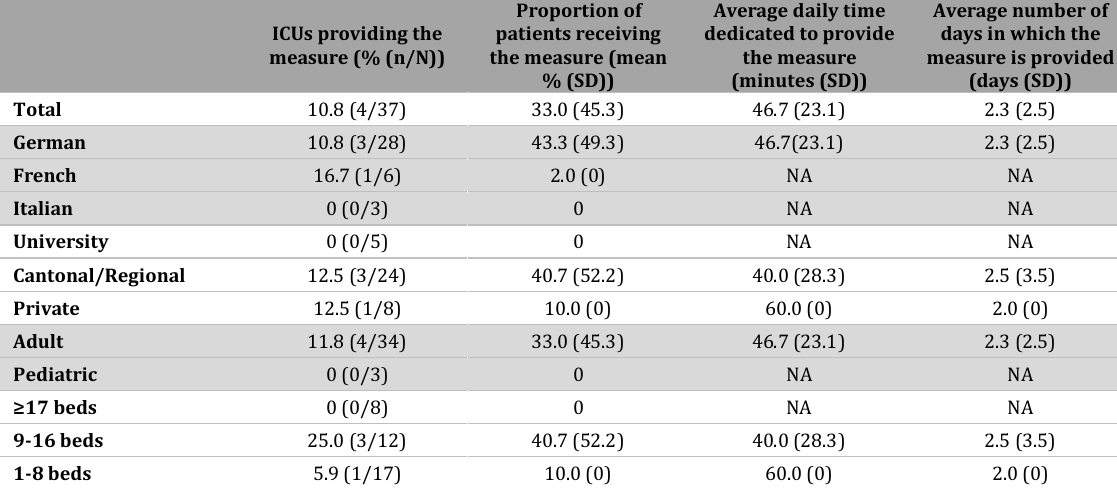
Table S6. Neuro-muscular electrostimulation